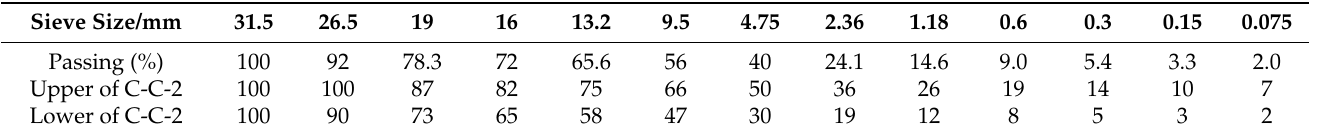
Table 9. Coal gangue particle